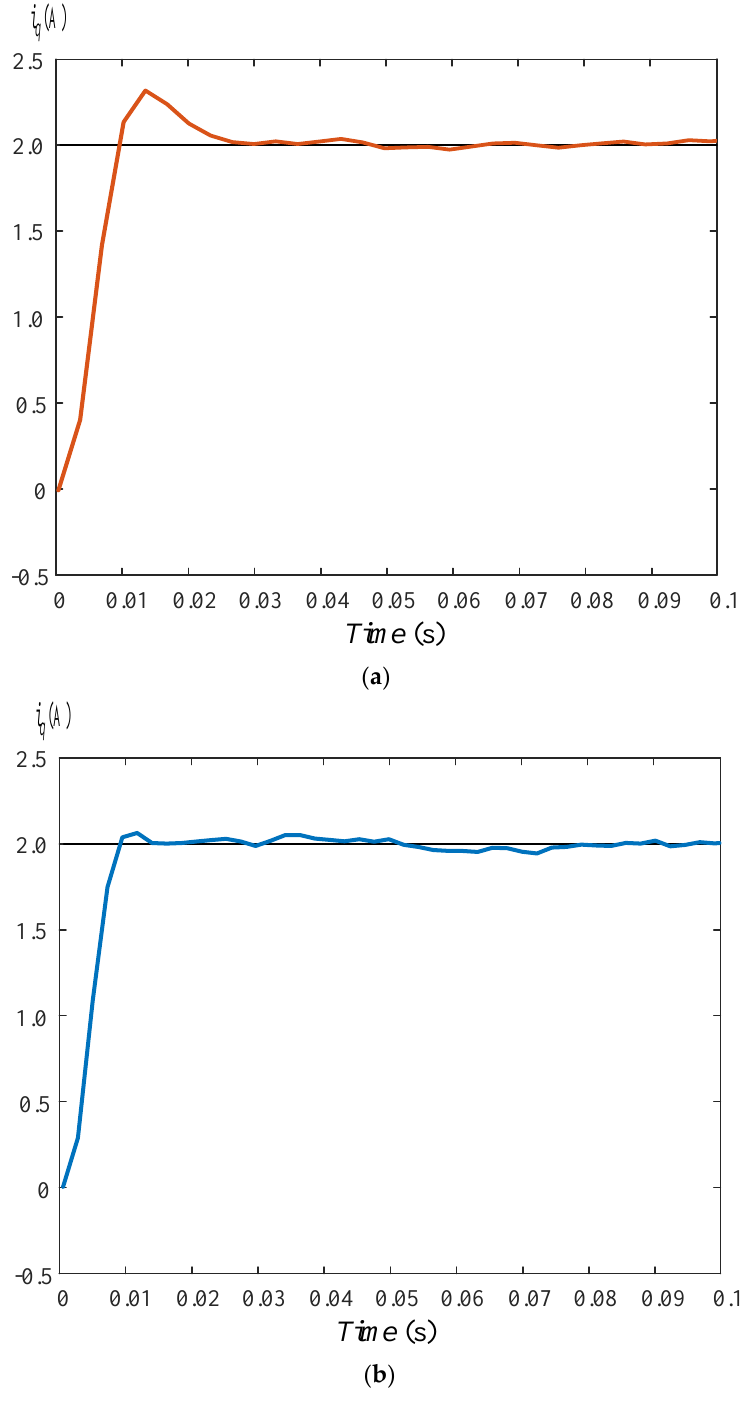
Figure 12. Measured speed responses. ( a ) Step-input responses, ( b ) load-disturbance responses.